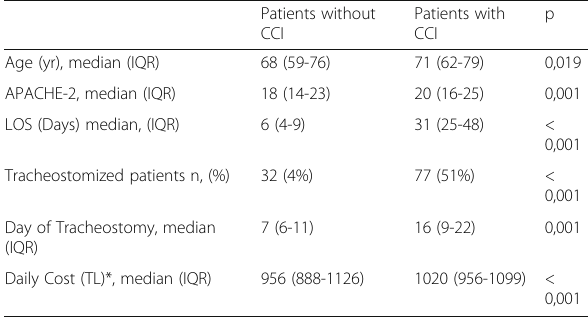
Table 1 (abstract 001028). Characteristics of Patients With and Without